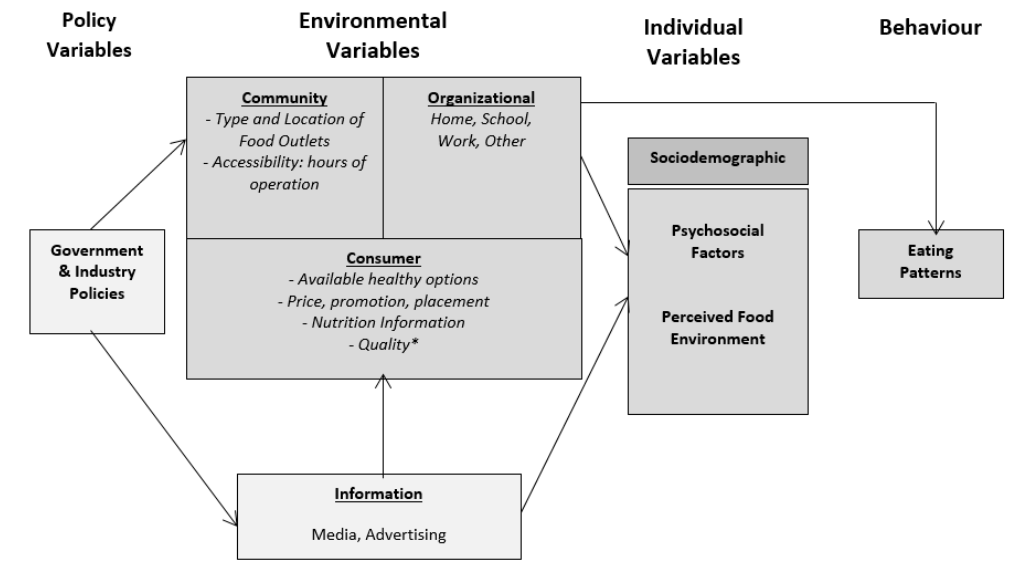
Figure 1. Food Environment Conceptual Model (adapted) [17]. * Quality has also been included as an aspect of the consumer food environment in this review.